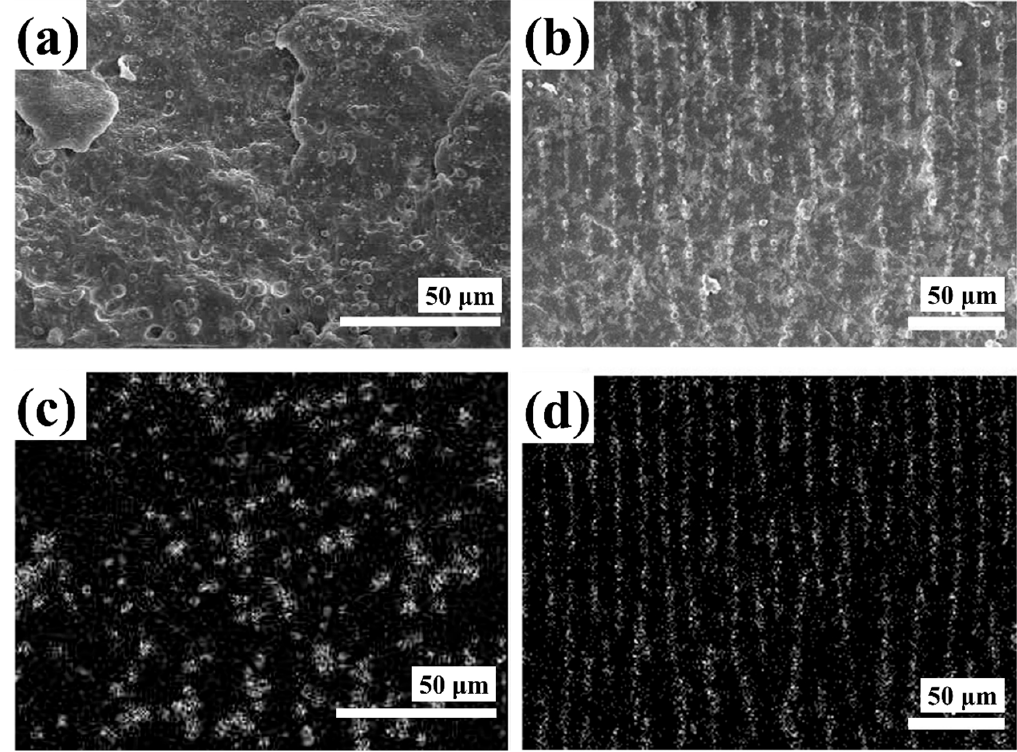
Figure 2. SEM and Fe-mapping images of the pure carbonyl iron (CI) particles incorporated in the natural rubber (NR)-based isotropic ( a , c ) (reprinted with permission from [50], Copyright 2016 Elsevier B. V., New York, NY, USA) and anisotropic ( b , d ) MR elastomers (reprinted with permission from [79], Copyright 2017 Elsevier B. V., New York, NY, USA).